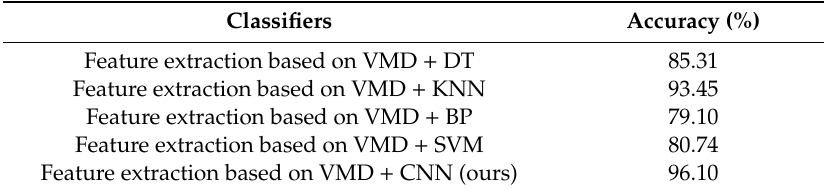
Table 5. Comparison of di ff erent